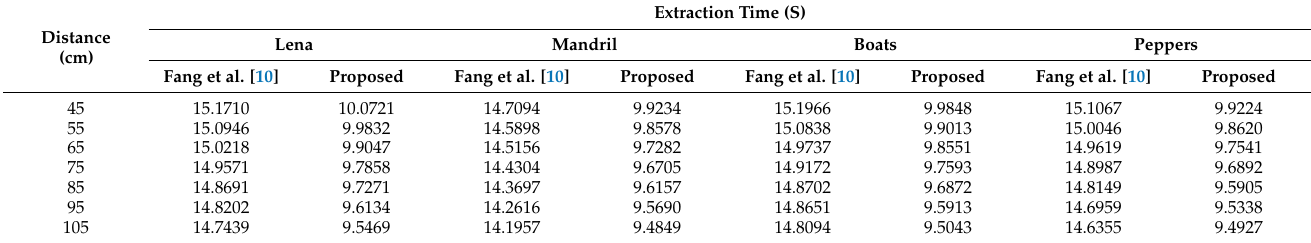
Table 10. Watermark extraction time at different distances from the screen.